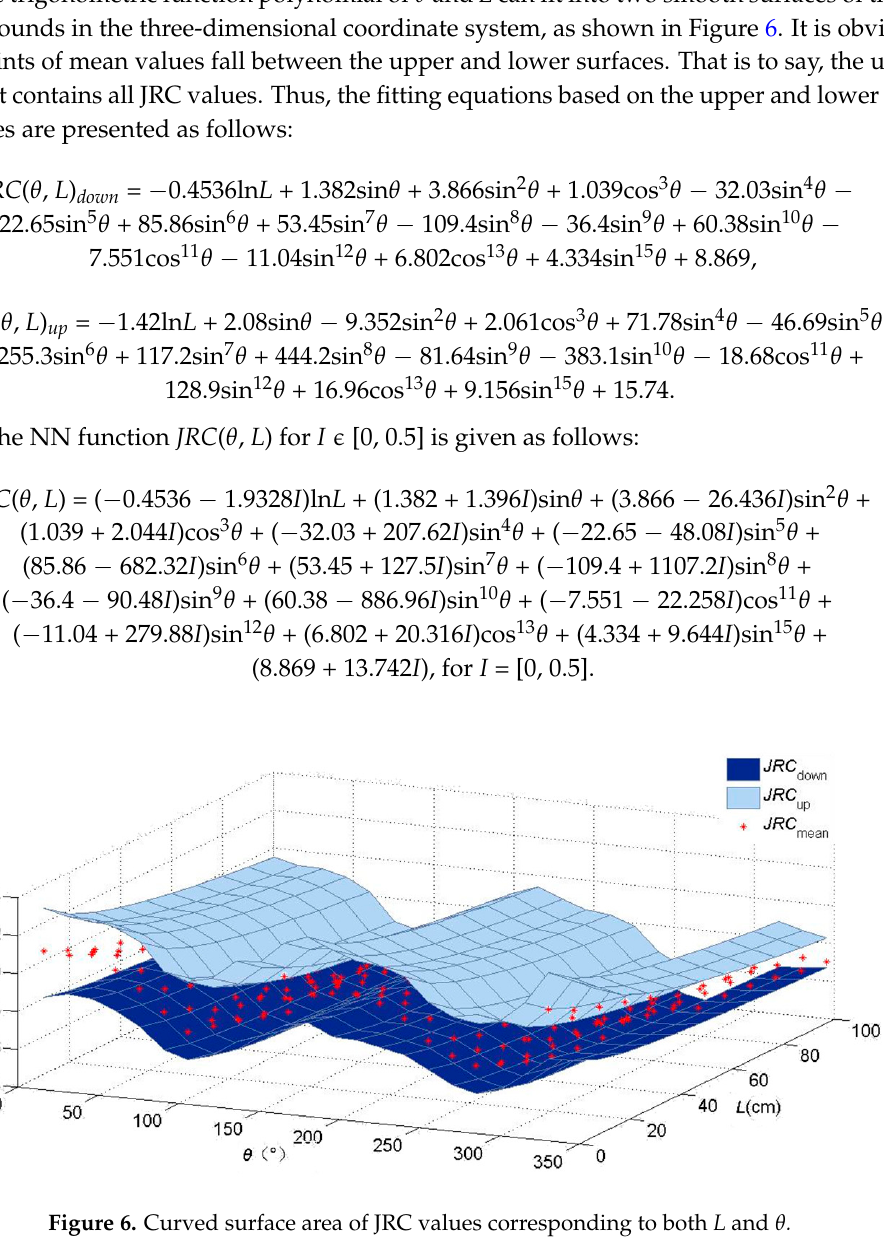
Figure 7. The changing rates of the scale effect. 0